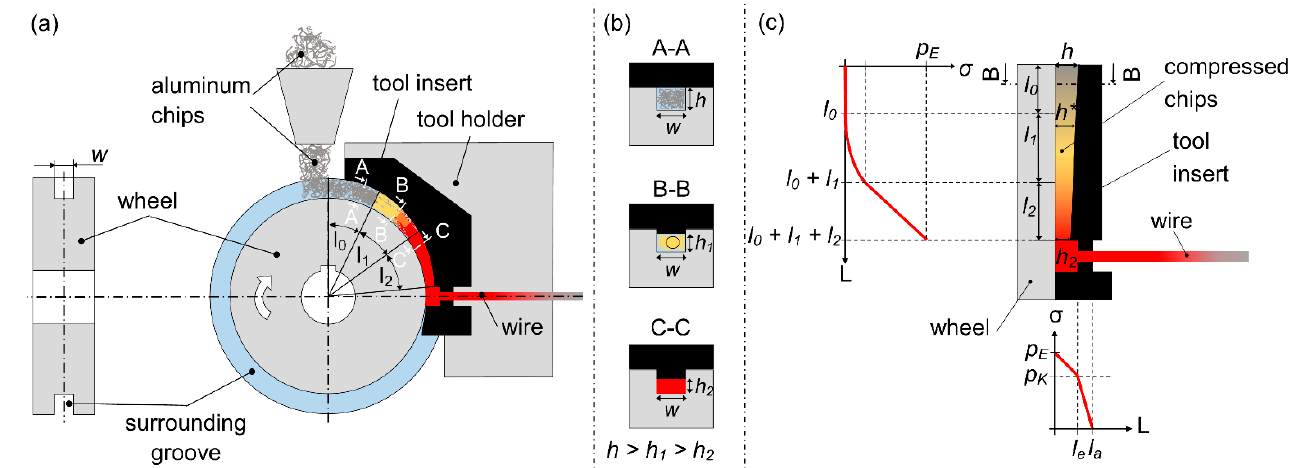
Figure 1. Tooling concept of the friction-induced recycling process of (aluminum) chips. ( a ) Machine assembly. ( b ) Cross-section reduction of the wheel groove by the tool. ( c ) Distribution of the extrusion pressure inside the groove and the die.